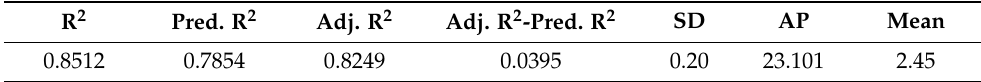
Table 4. Evaluation of the selected model for compressive strength. R